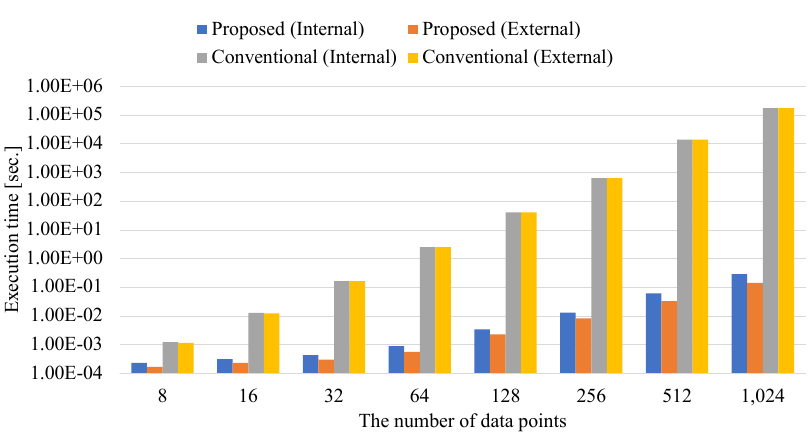
Figure 8. Total execution time of preprocessing for